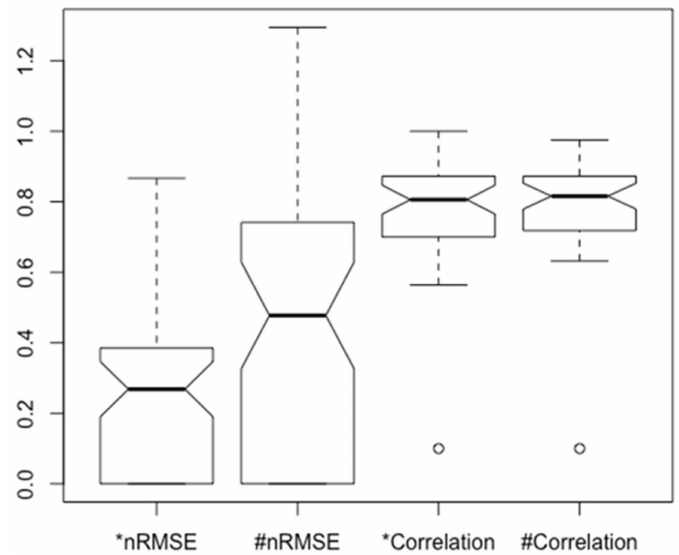
Figure 9. Boxplot of nRMSE and correlation of downscaled soil moisture and original AMSR-2 derived soil moisture, with the in-situ surface soil moisture at 44 validation sites. * Is for metrics between downscaled soil moisture and in-situ surface soil moisture. # Is for metrics between AMSR-2 soil moisture and in-situ surface soil